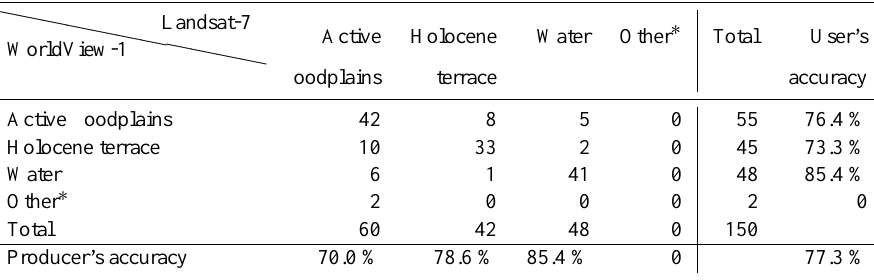
Table 7. Accuracy assessment of Landsat-based geomorphic land unit classification for the Holocene terrace, the active floodplain and water, using high-resolution WorldView-1